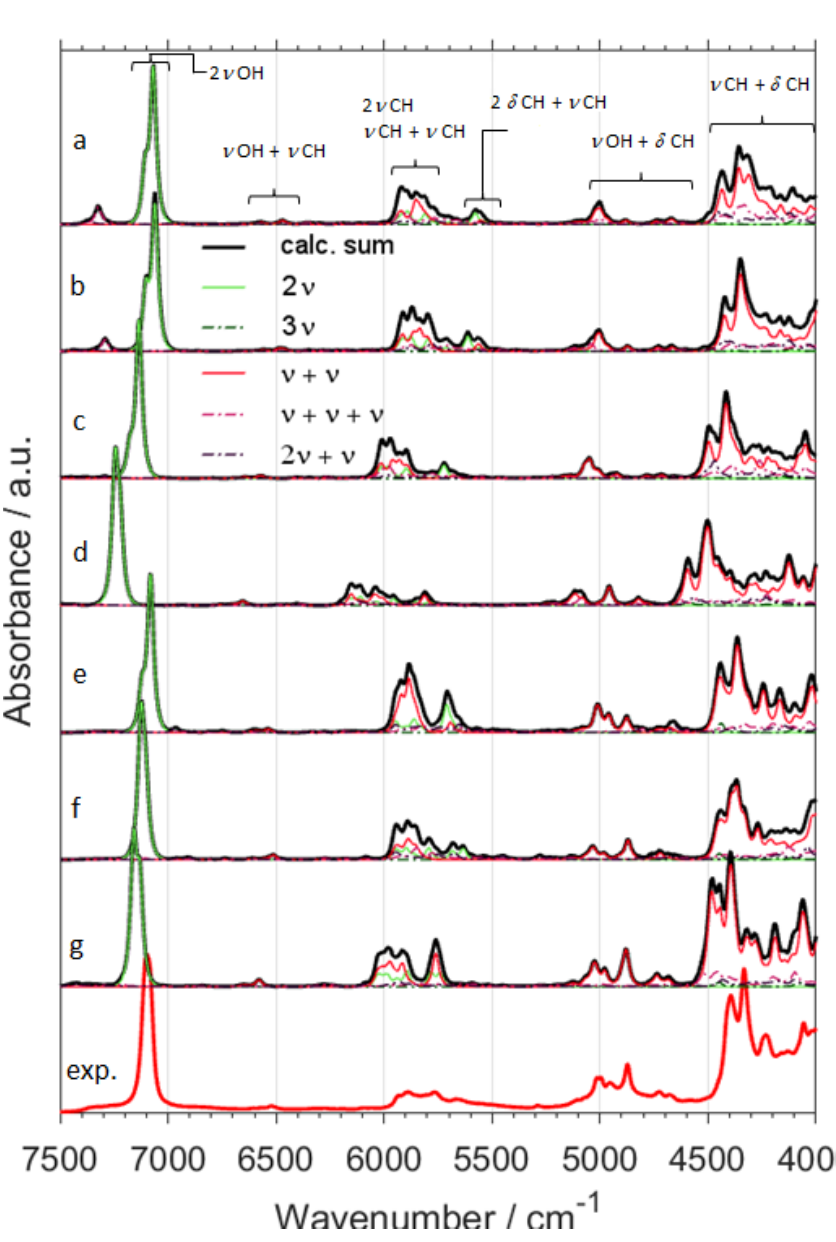
Figure 1. NIR spectra of CH 3 CH 2 OH calculated with GVPT2 method at different levels of electronic theory; ( a ) B3LYP-GD3BJ / 6-31G(d,p); ( b ) B3LYP-GD3BJ / 6-31G(d,p) // CPCM; ( c ) B2PLYP-GD3BJ / 6-31G(d,p) // CPCM; ( d ) MP2 / 6-31G(d,p) // CPCM; ( e ) B3LYP-GD3BJ / SNST // CPCM; ( f ) B2PLYP-GD3BJ / def2-TZVP // CPCM; ( g ) MP2 / aug-cc-pVTZ // CPCM; ( exp. ) Experimental spectrum of CH 3 CH 2 OH in CCl 4 (0.1 M).